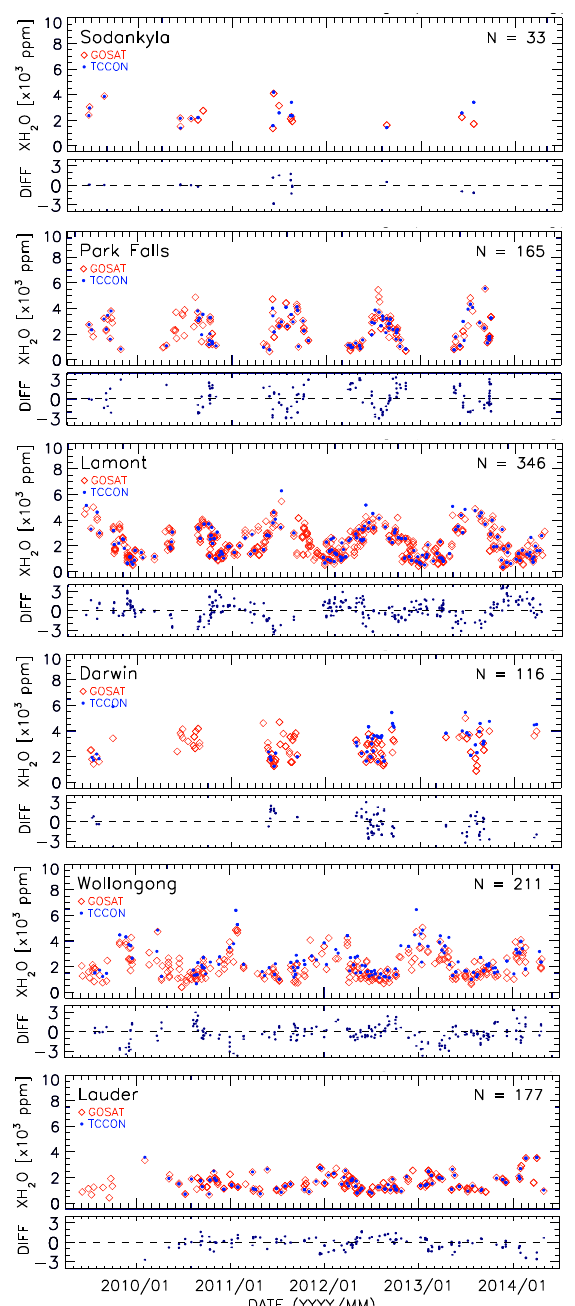
Figure 7. Correction of Figure 7 in [1]. Time series of XH 2 O at six TCCON sites for collocated TANSO-FTS data ( ± 1 ◦ latitude/longitude, no time constraint) and for the average of TCCON measurements acquired within ± 30 min of a GOSAT overpass. TCCON sites are ordered from top to bottom by decreasing latitude. For each site, the top panel shows the XH 2 O time series of GOSAT (red diamonds) and TCCON (blue circles). Bottom panel: absolute differences (GOSAT − TCCON) for spatially- and temporally-coincident